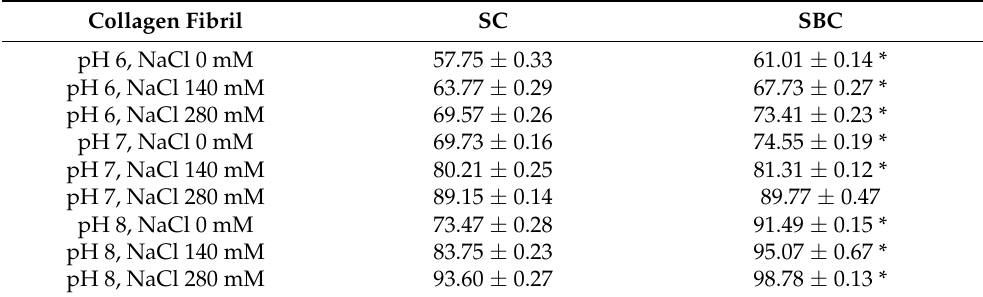
Figure 9 . Morphological observation of C. idella swim bladder collagen (SBC) fibrils under different salinity and pH: ( A – C ) collagen with NaCl concentration of 0, 140, and 280 mM and pH 6; ( D – F ) collagen with NaCl concentration of 0, 140, and 280 mM and pH 7; ( G – I ) collagen with NaCl con- centration of 0, 140, and 280 mM and pH 8. Scale bars, 2 μm.